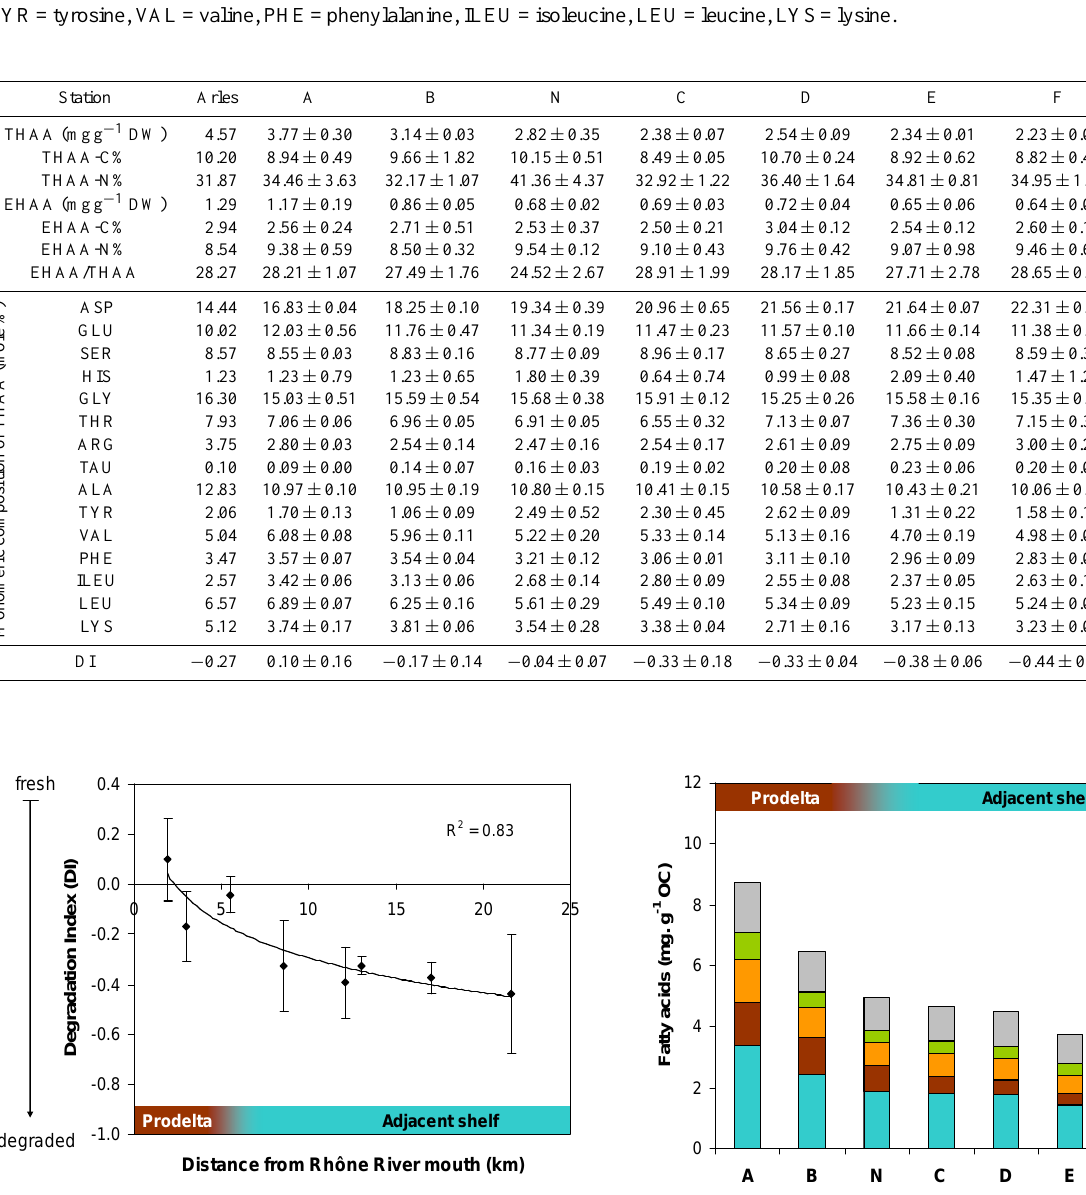
Table 2. Total (THAA) and enzymatically amino acid (EHAA) concentrations, contribution of THAA and EHAA to total organic carbon (THAA-C% and EHAA-C%) and total nitrogen (THAA-N% and EHAA-N%), EHAA/THAA ratio, amino acid composition as mole% and Degradation Index (DI) in the suspended matter from the Rhˆone River (Arles station), surface sediments along the southwestern longitudinal transect (A, B, N, C, D, E and F) and the marine reference site (J). Means ± standard deviation ( n = 3). ASP=aspartic acid, GLU=glutamic acid, SER=serine, HIS=histidine, GLY=glycine, THR=threonine, ARG=arginine, TAU=taurine, ALA=alanine,